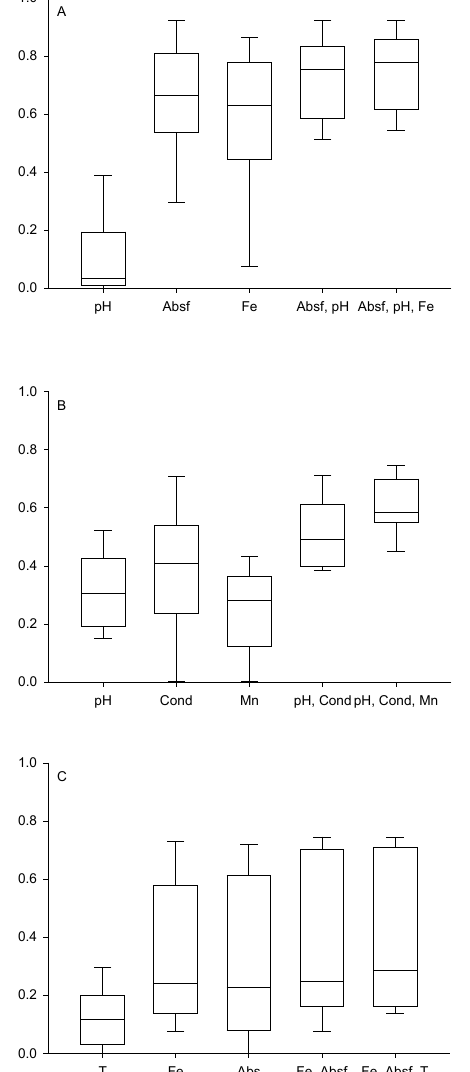
Fig. 2. Variables included in each common model for Pb (A) , Zn (B) Figure 2. Variables included in each common model for Pb (A), Zn (B, Aneboda removed), (Aneboda IM removed), and Cr (C) . Box plots are shown with me- and Cr (C). Box plots are shown with medians, 25 and 75 th quantiles and 10 and 90% dians, 25 and 75th quantiles, and 10 and 90% quantiles (whiskers). quantiles (whiskers).